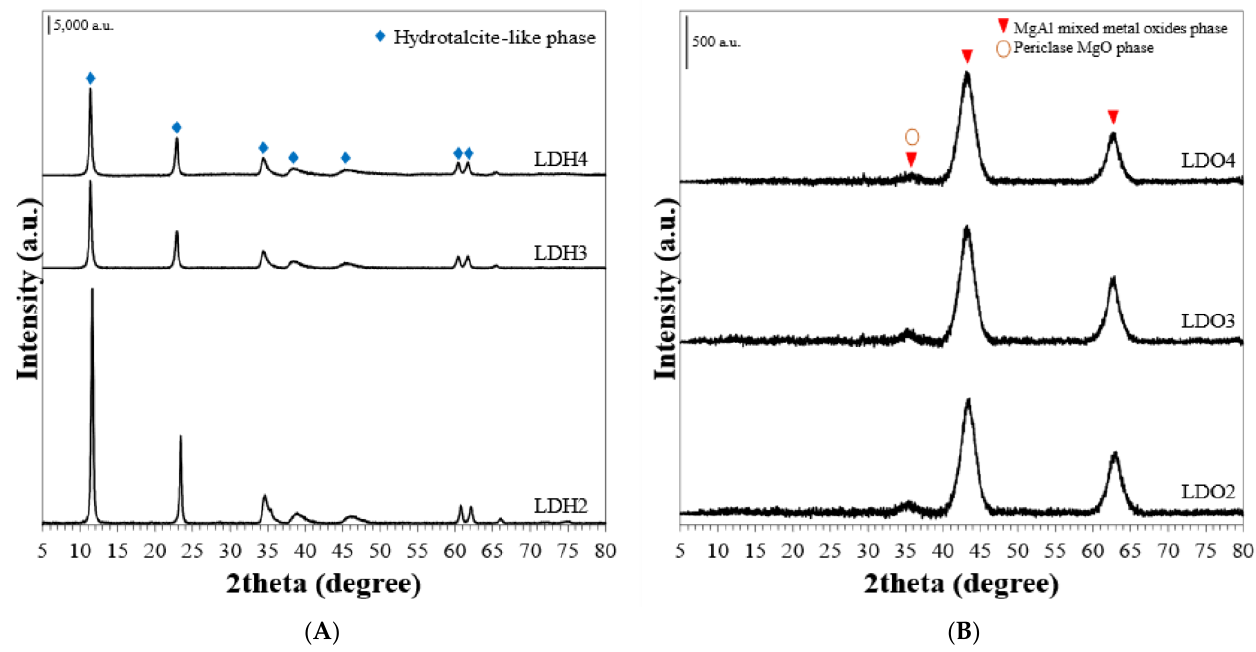
Figure 1. XRD patterns of ( A ) as-synthesized and ( B ) calcined LDH samples.